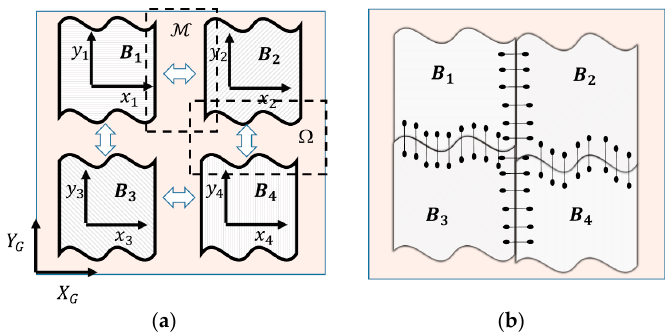
Figure 3. Windowing technique in global and local coordinates: ( a ) Multiple patches; ( b ) Warping.